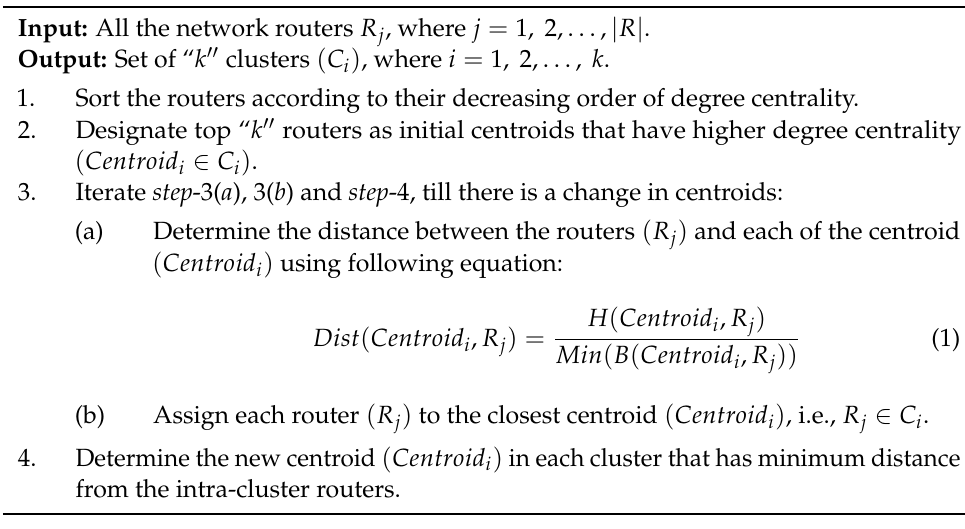
Algorithm 1: Proposed network clustering